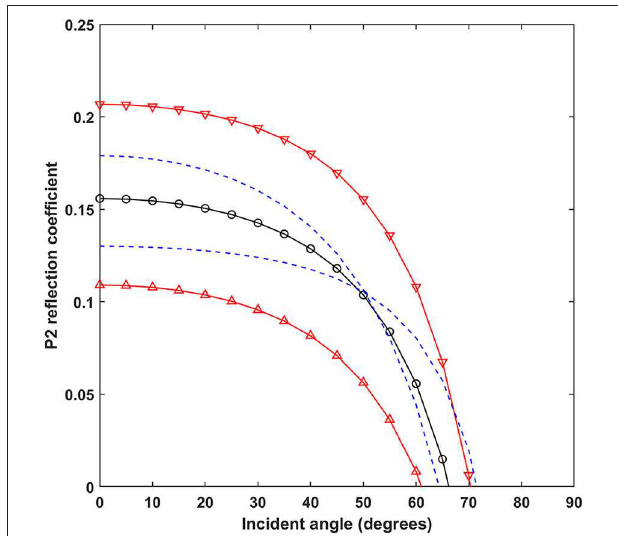
FIGURE 2 | Theoretical reflection coefficient calculated using Equation (2). The black line with circles is the reflection coefficient calculated as a function of angle for parameter values of porosity φ solid lines with triangles pointing up/down have porosity values increased/decreased by 10% (0.80, 0.72). Blue dashed lines have modified tortuosity values of (1.32, 1.08).